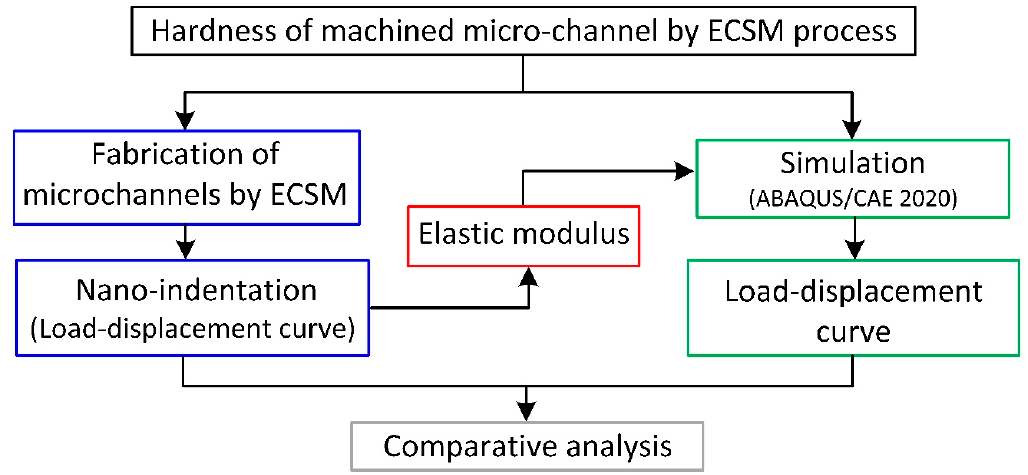
Figure 2. Workflow plan.